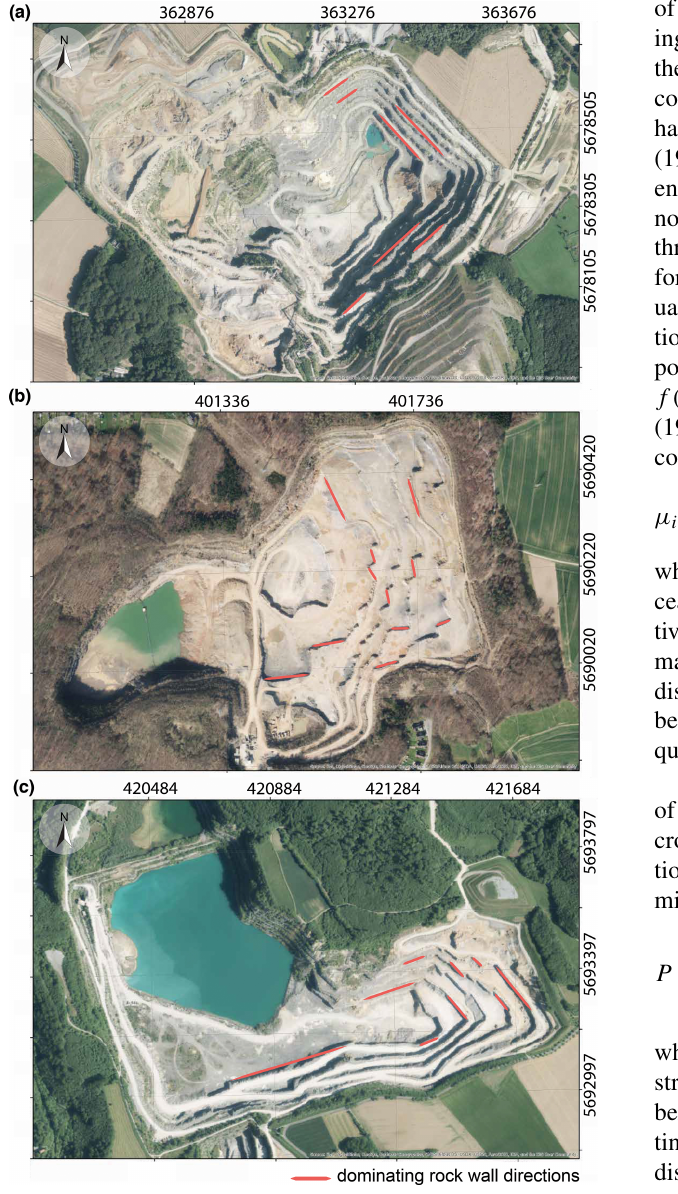
Figure 3. Map view of all three study areas in which scanline sur- veys were carried out: (a) the Osterholz stone pit, which is oper- ated by Kalkwerke H. Oetelshofen GmbH & Co. KG in Wupper- tal; (b) the Oege stone pit, operated by Hohenlimburger Kalkw- erke GmbH in Hagen-Hohenlimburg; (c) the Asbeck rock mine, managed by Lhoist Deutschland, Rheinkalk GmbH in Hönnetal. Red lines indicate the predominant rock walls, i.e. the direction of the mining. In each of the three outcrops there were two dom- inant mining directions, which were approximately perpendicu- lar to each other. This figure was created using ArcGIS ® soft- ware by Esri (Basemap, World Imagery: http://www.arcgis.com/ home/item.html?id=10df2279f9684e4a9f6a7f08febac2a9, last